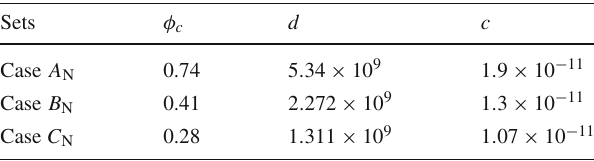
Table 3 The parameter sets for PBHs production in natural inflation model.Theparameters φ c and c areinunitsof M pl = 1.Here, M = 1 . 7, α = − 1, and f =